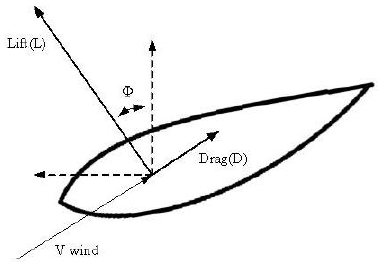
Figure 2. Lift and drag force of blade airfoil.